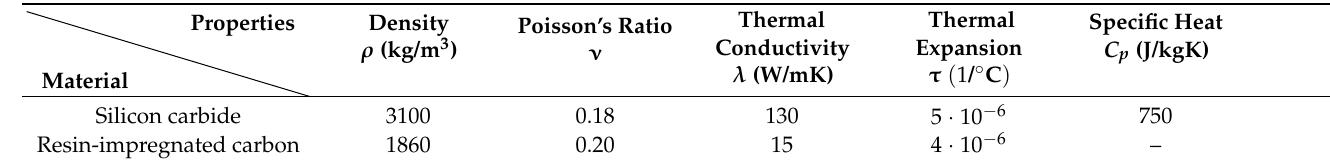
Table 1. Properties of the rotor and stator materials.